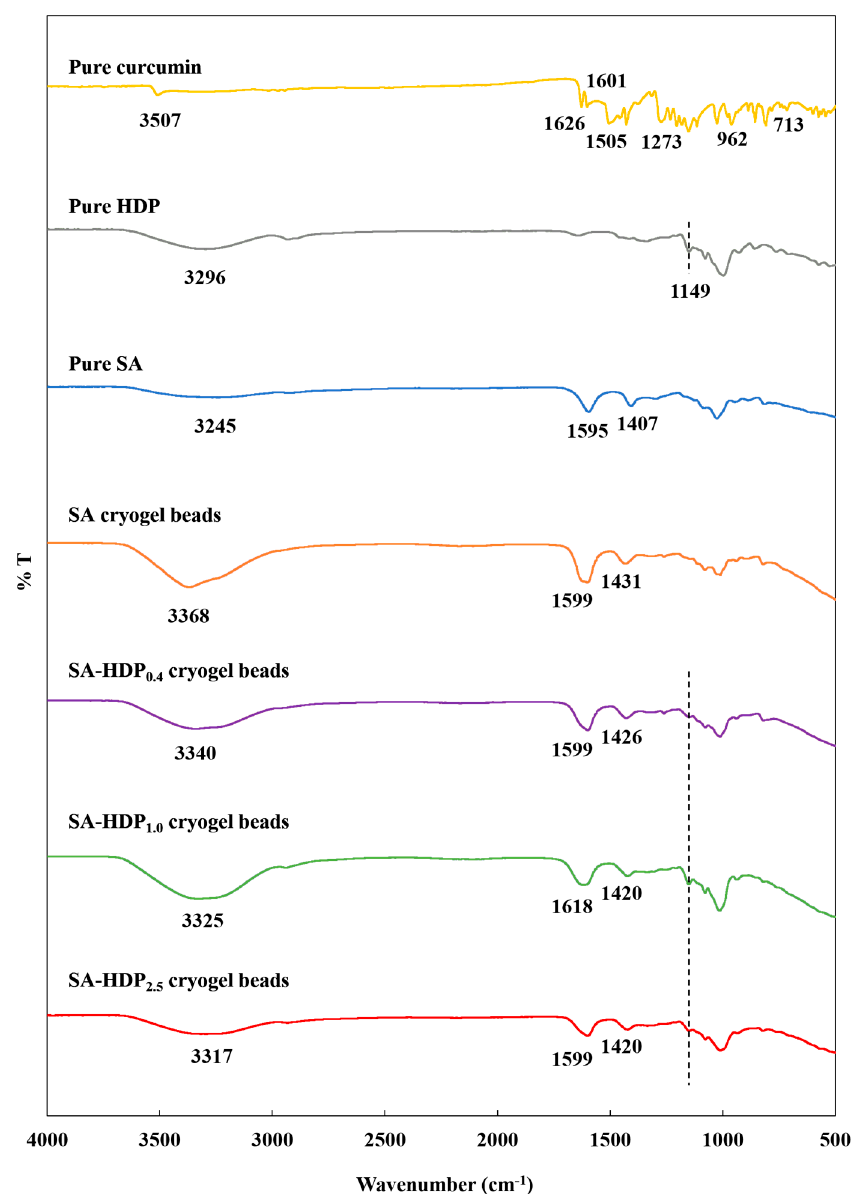
Figure 4. FT − IR spectrum of pure hydroxypropyl distarch phosphate (HDP), pure sodium alginate (SA), pure curcumin, and SA-based cryogel beads filled with different concentrations of HDP. SA cryogel beads, SA-HDP 0.4 cryogel beads, SA-HDP 1.0 cryogel beads, and SA-HDP 2.5 cryogel beads represent cryogel beads filled with different concentrations of HDP (0, 0.4, 1.0, and 2.5%, respectively).